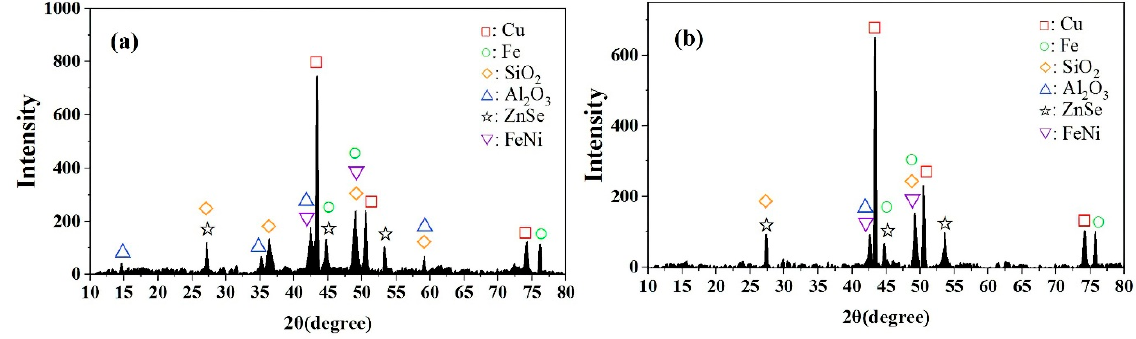
Figure 6. XRD patterns of PCB sample ( a ) and GRF ( b ).